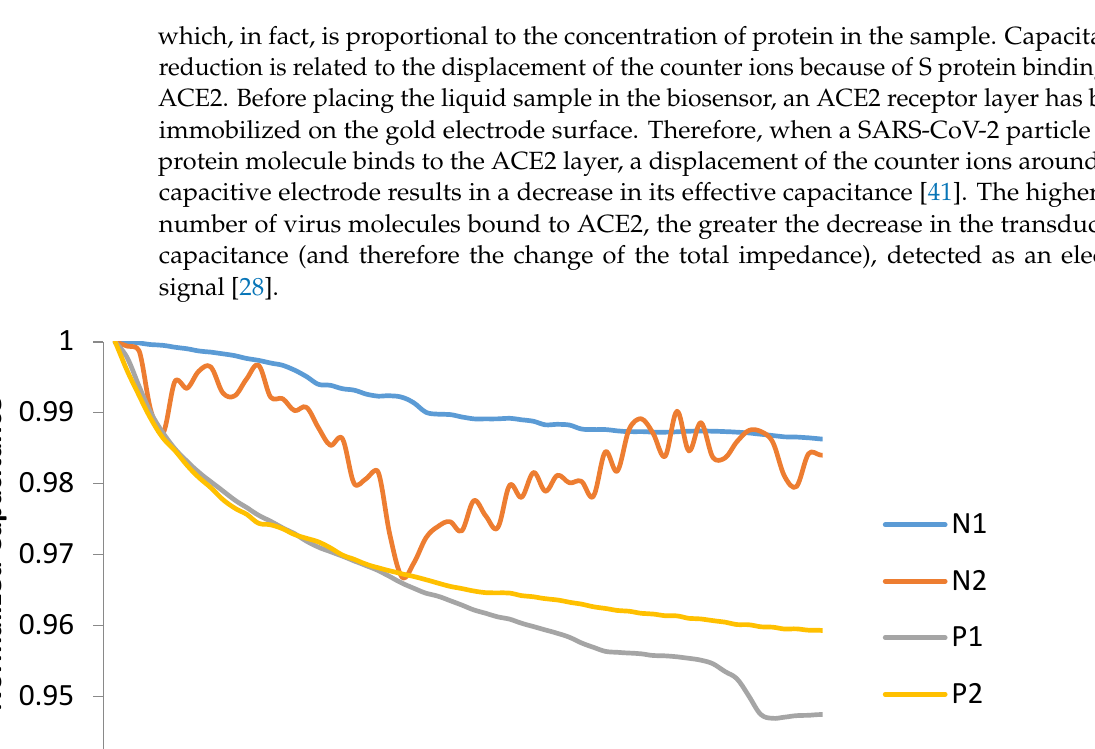
Figure 7. Normalized capacitance change over time for 4 swab samples, 2 negative to the virus (N1, N2) and 2 positive to the virus (P1, P2).